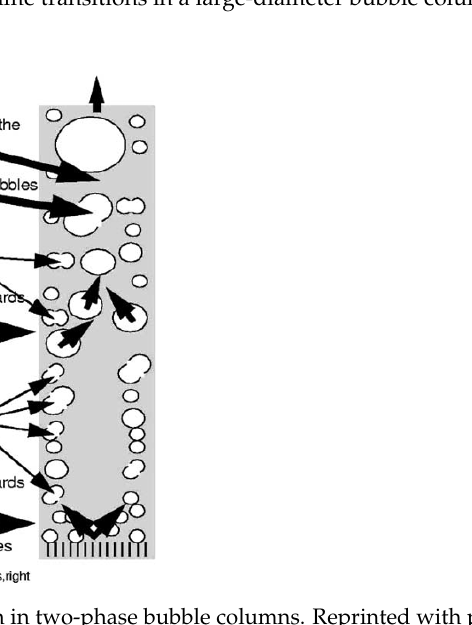
Figure 4. Flow pattern evolution in two-phase bubble columns. Reprinted with permission from